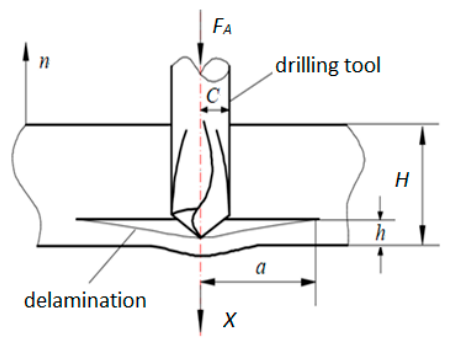
Figure 11. Circular plate model for drilling CFRP.